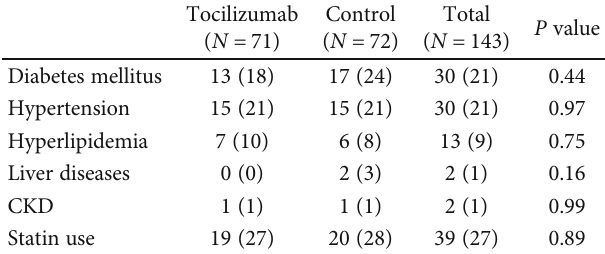
Table 3: Clinical characteristics at baseline: concomitant